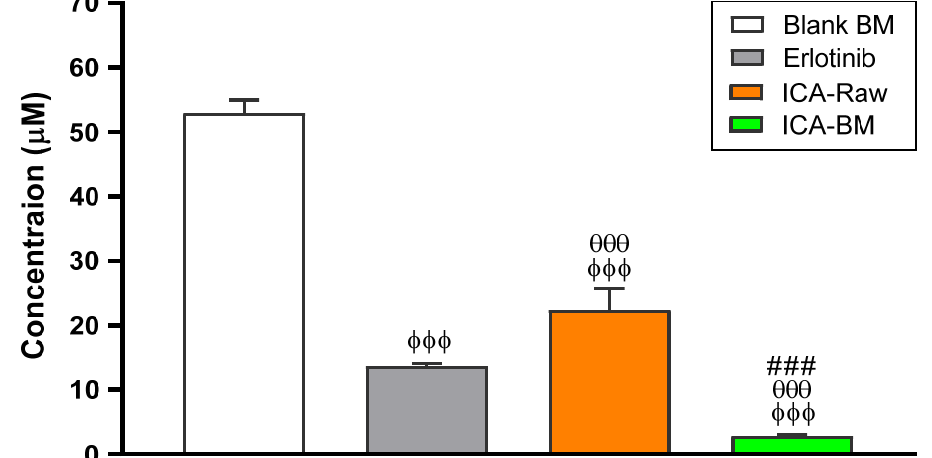
Figure 4. IC 50 of the Blank BM, erlotinib, ICA-Raw, and ICA-BM in the PANC1 cells. Data are the mean of 4 independent experiments ± standard deviation (SD). φφφ Significantly different vs. Blank BM ( p < 0.001); θθθ Significantly different vs. Erlotinib ( p < 0.001); ### Significantly different vs. ICA-Raw ( p < 0.001).